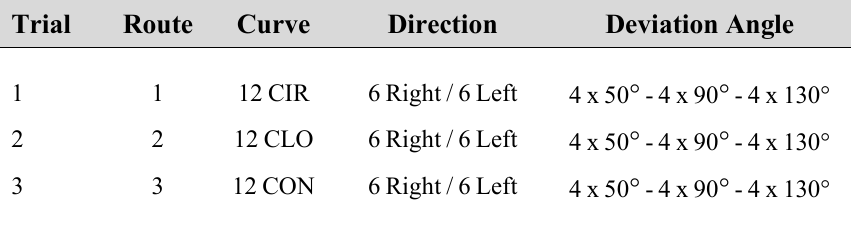
Table 3 Routes participants completed